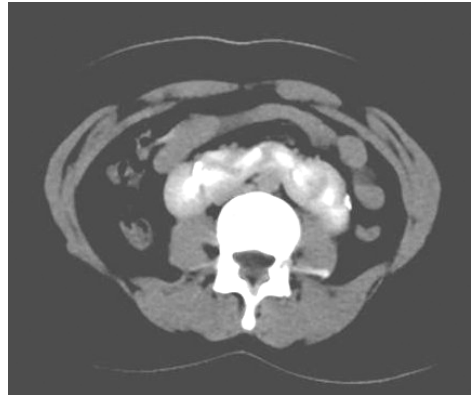
Figure 2 - Contrast Enhanced CT scan showing left side upper moiety ureter (marked by arrow), along with the left lower moiety and right side two moieties one placed right to vertebra and another lies over the